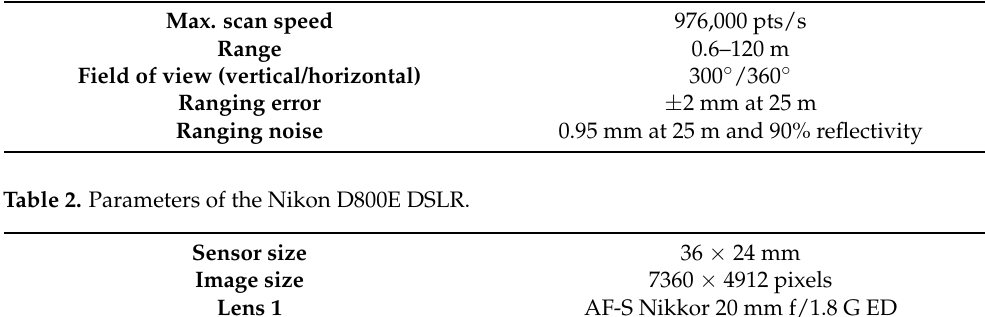
Table 1. Trimble TX5 Laser Scanner Parameters.